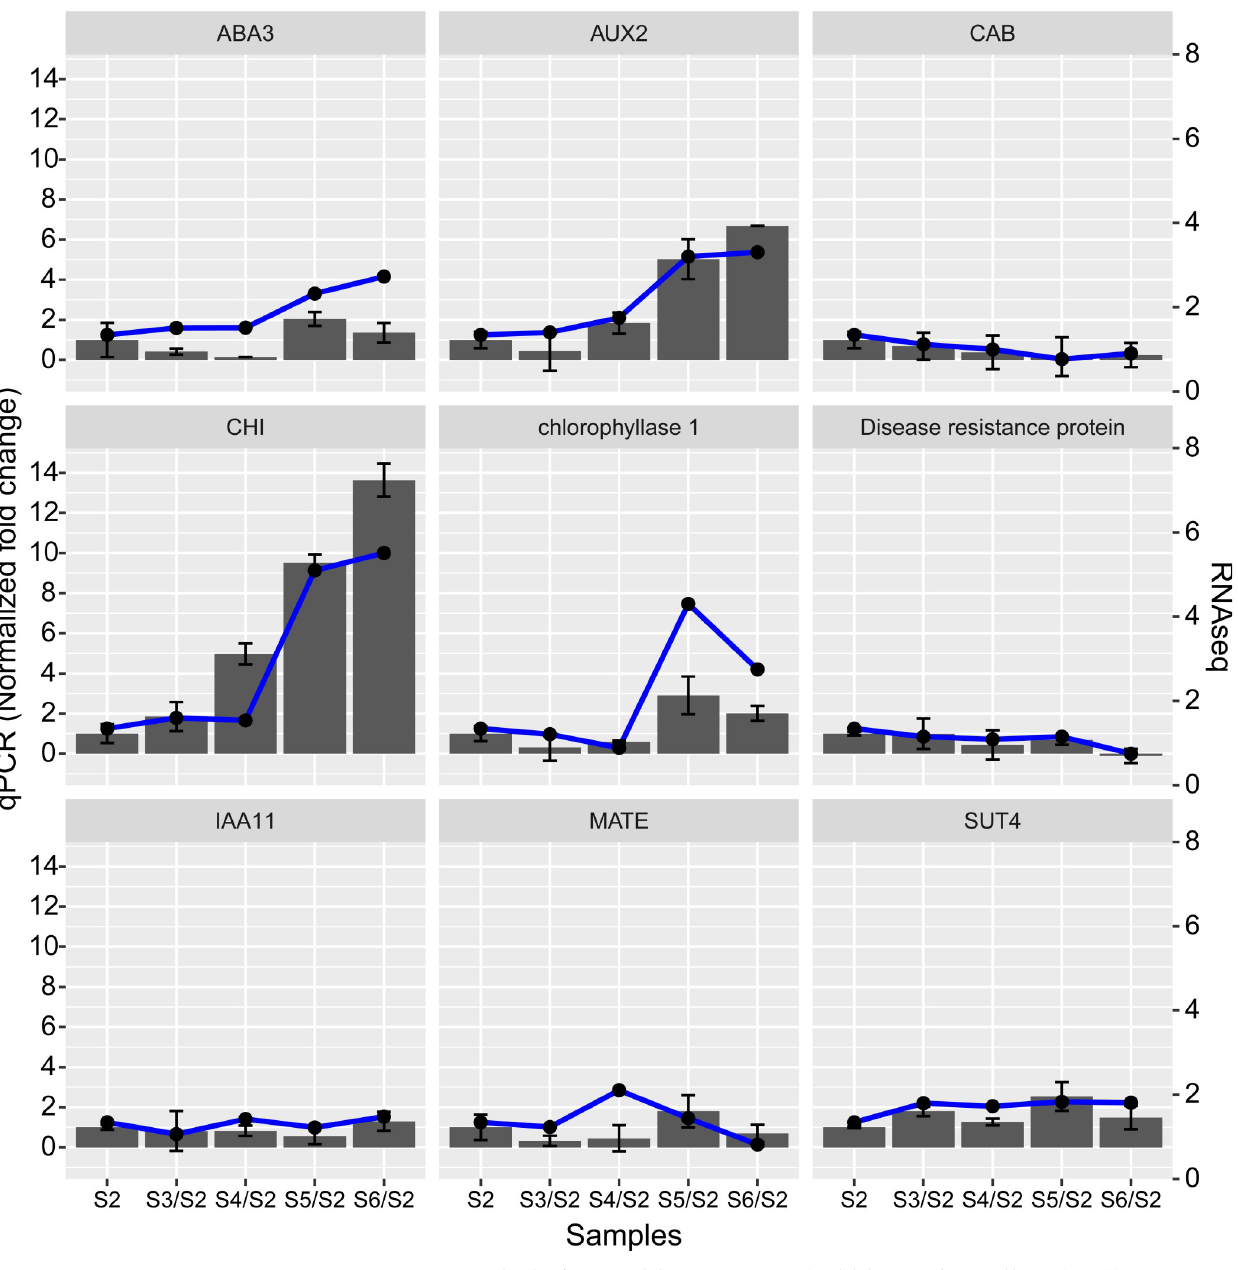
Fig 5. Validation of gene expression by qRT-PCR. Expression levels of nine candidate genes— ABA3 ( molybdenum cofactor sulfurase ( LOS5 )), AUX2 ( auxin transporter-like protein 2 ), CAB ( chlorophyll A-B binding family protein ), CHI ( chalcone-flavanone isomerase family protein ), CLH1 ( chlorophyllase 1 ), Disease resistance protein (CC-NBS-LRR class) family member, IAA11 ( indole-3-acetic acid inducible 11 ), MATE (encoding a MATE efflux family protein), and SUT4 ( sucrose transporter 4 )—were determined at each stage using qRT-PCR analyses. S2, S3/S2, S4/S2, S5/S2 and S6/S2 represent flower bud, initial flower, bloom flower, pad fruit and cup fruit, respectively. The bars and error bars (Standard Deviation) represent the qPCR while the line represents the results of RNA-seq.